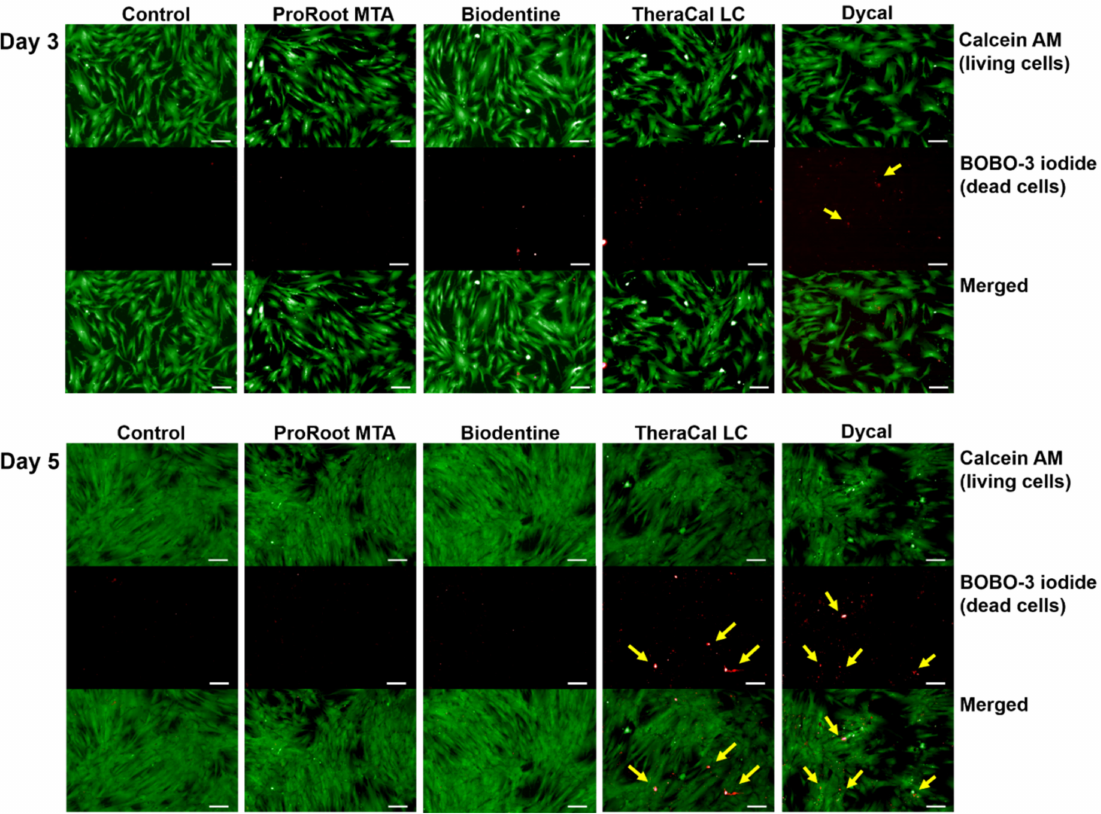
Figure 3. Representative images of cell viability in the presence of various pulp capping materials. Cells were double-stained with LIVE/DEAD cell stain. Upper panels show live hDPSCs ( green ); middle panels show dead hDPSCs ( red ); lower panels show superimposed images (scale bar = 200 µ m). Arrows indicate dead cells in the TheraCal LC and Dycal